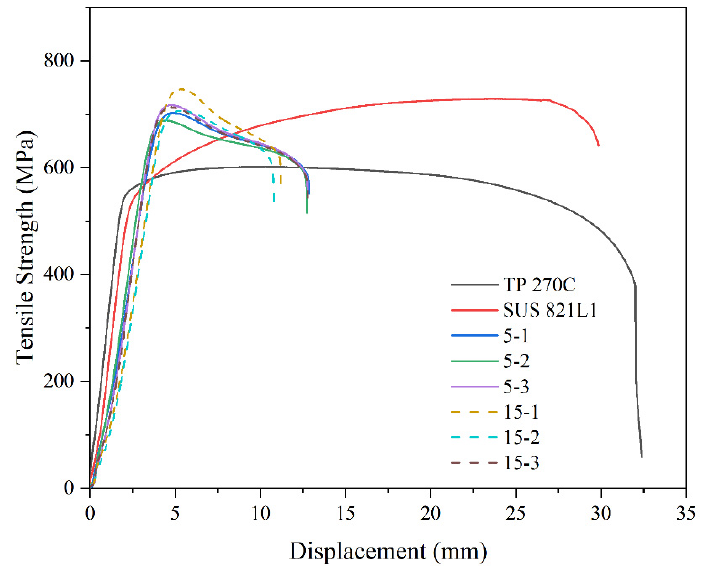
Figure 3. Tensile curves.